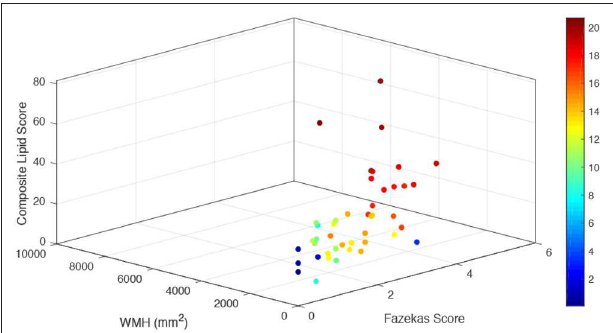
FIGURE 3 | Relationship of combined LS with subjective and objective white matter hyperintensity measurements. For each stroke mimic cohort subject, combined lipid score values are plotted on the vertical z axis (arbitrary units) as a function of measured white matter hyperintensities (mm 2 ) (left bottom axis) and Fazekas score (right bottom axis). Color scale corresponds to the summated log-normalized composite of each input variable (LS, WMH area, and FS).